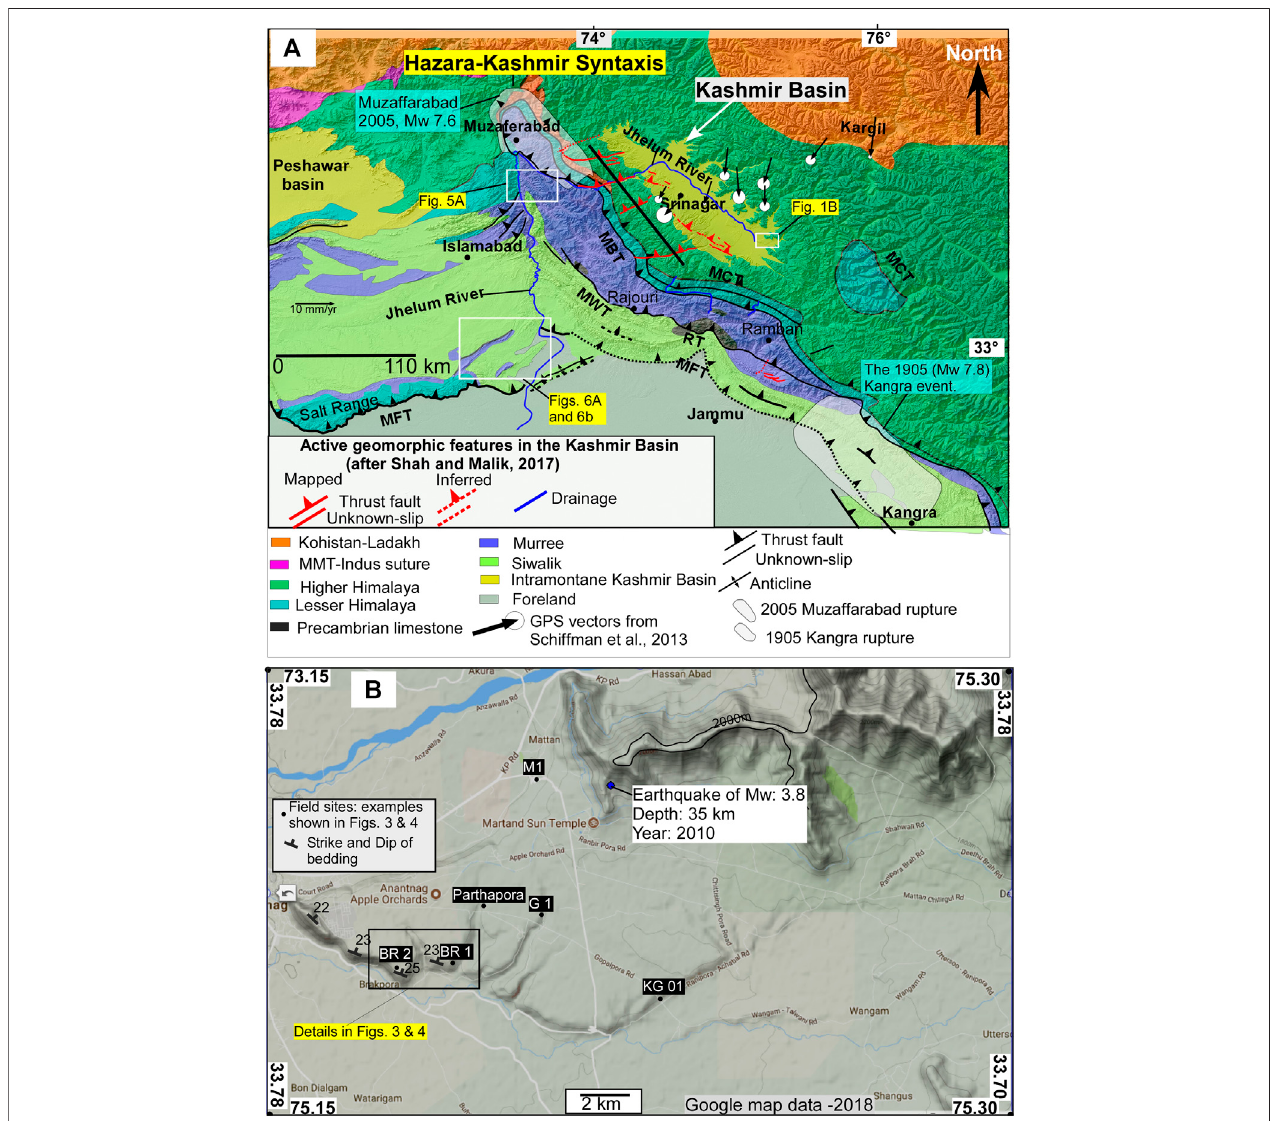
FIGURE 1 | Location map of the Kashmir and Peshawar basins (A) with traces of major geological structures and rock units in NW Himalaya. The GPS velocity vectors are also plotted on the map to show the active plate convergence in the Kashmir region (after Vassallo et al., 2015; Shah and Malik, 2017). (B) The fi eld sites are shown on the Google terrain map along with the information on strike and dip of geological units that are exposed at Anantnag, Kashmir. The details of two sites (BR-1 andBR-2)areshownin Figures3,4 .MBT,mainboundarythrust;MCT,maincentralthrust;MFT,mainfrontalthrust;MWT,Medlicott – Wadiathrust;RF,Riasifault.